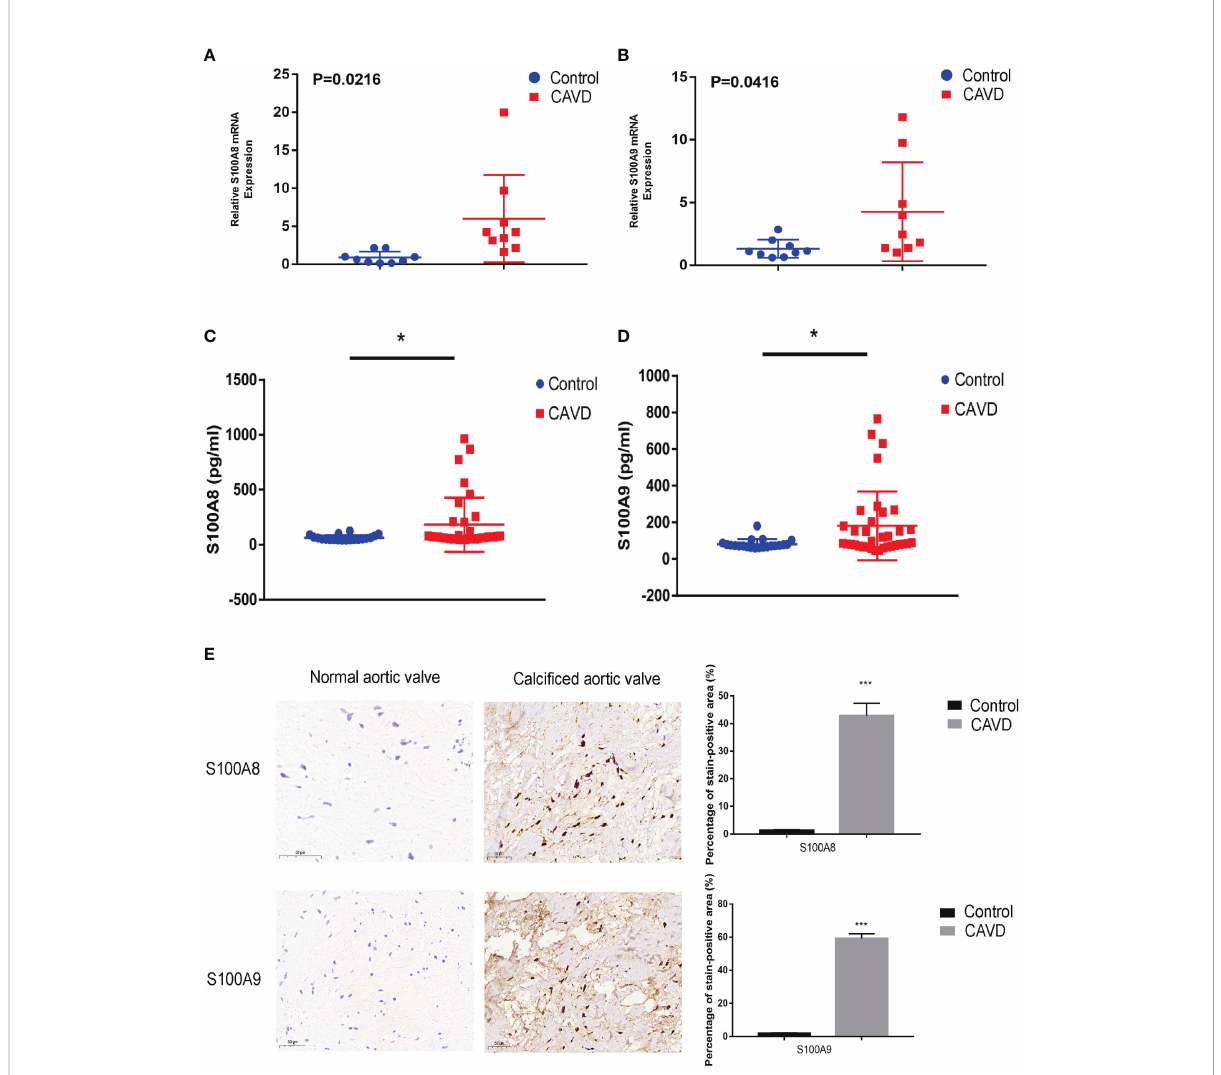
FIGURE 12 Validation of S100A8 and S100A9 expression in human samples. RT-PCR analysis of samples from nine patients with calci fi c aortic valve disease (CAVD) and nine normal patients. The expression of S100A8 (A) and S100A9 (B) was signi fi cantly higher in calci fi ed aortic valves than in normal aortic valves ( P < 0.05). Expression of S100A8 (C) and S100A9 (D) in human serum (n = 55), as determined by ELISA. (E) Immunohistochemical analysis and quantitative data con fi rmed S100A8 and S100A9 expression in calci fi ed aortic valves. * P< 0.05, *** P< 0.001 when two groups were compared as indicated or compared to the corresponding control. Ns indicates non-signi fi